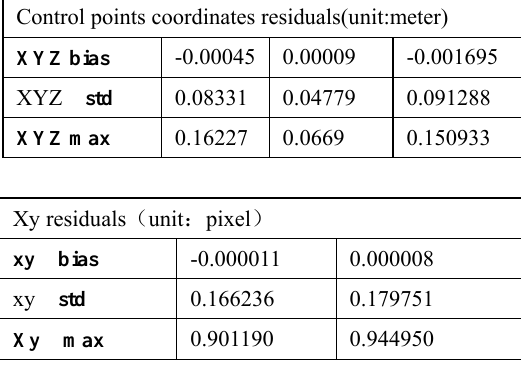
Table 1. Accuracy of the UCD project